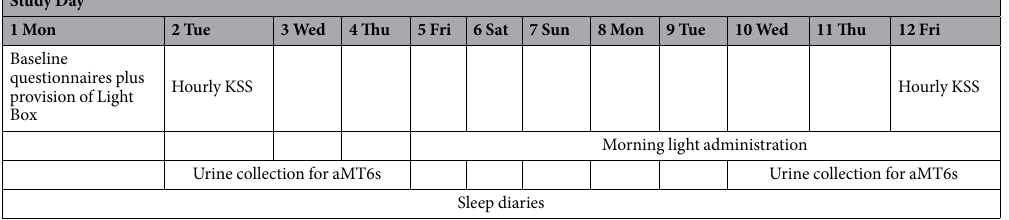
Table 5. Light administration study design. aMT6s: 6-sulphatoxymelatonin. KSS: Karolinska Sleepiness